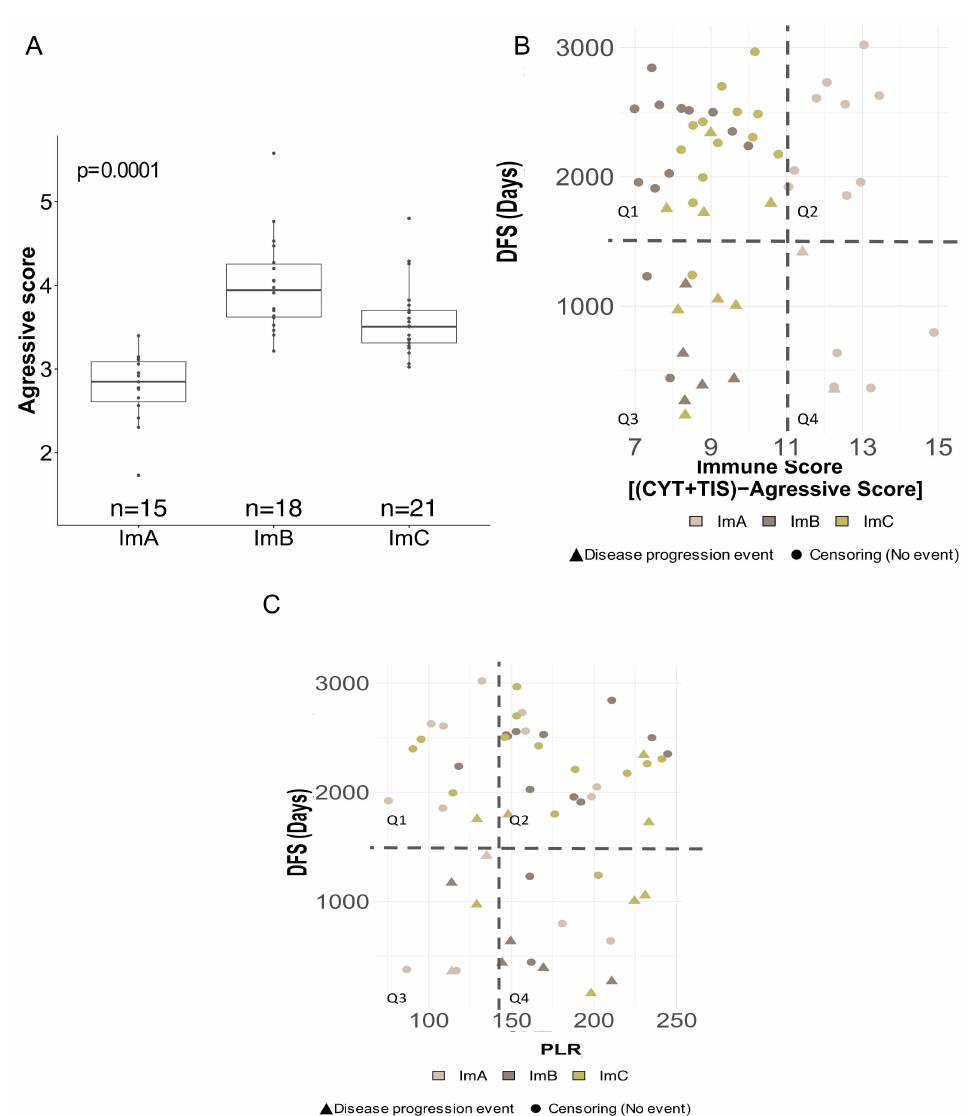
Figure 5. Clinical relevance of local and systemic inflammatory markers ( A ) Boxplot of computed aggressive score among Im-Clus ( B ) Scatterplot of follow-up time (y-axis, time to event (days), cut-o ff mean value) vs Integrative immune score (IMS score), IMS = ((CYT × TIS) − Aggressive score) (x-axis, cut o ff mean value). In each plot four di ff erent quadrants are indicated (Q1, Q2, Q3, Q4) in accordance to their value to y and x values. Circle represents no progression / recurrence event while triangle represents event. Colors represent each Im-Clus as indicated by the legend color. ( C ) Scatterplot of follow-up time (y-axis, time to event (days), cut-o ff mean value) vs. PLR values (x-axis, (cut-o ff mean value of ImA